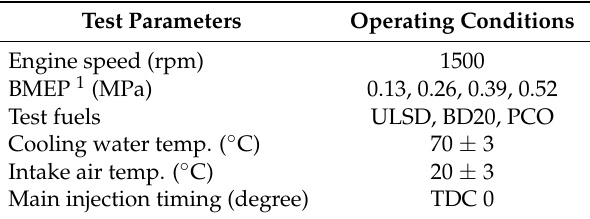
Table 2. Experimental and operating conditions.